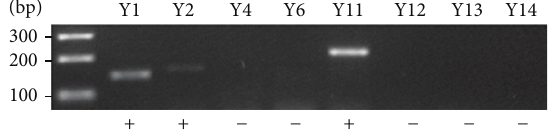
Figure 4: Comparative expression of human P2Y receptors in HT- 29cellsbysemiquantitativeRT-PCR.Arepresentativeexperimentof 𝑛 = 2 is shown. Presence (+) of P2Y 1 , P2Y 2 , and P2Y 11 was detected while the other P2Y receptors were not detected ( −